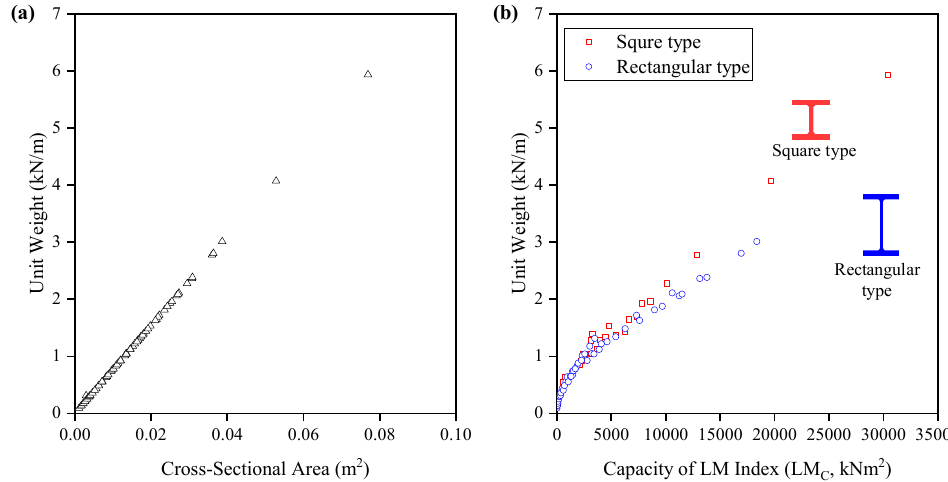
Figure 7. Unit weight of hot-rolled H-beam: ( a ) Cross-sectional area vs. unit weight and ( b ) capacity of LM index vs. unit weight.